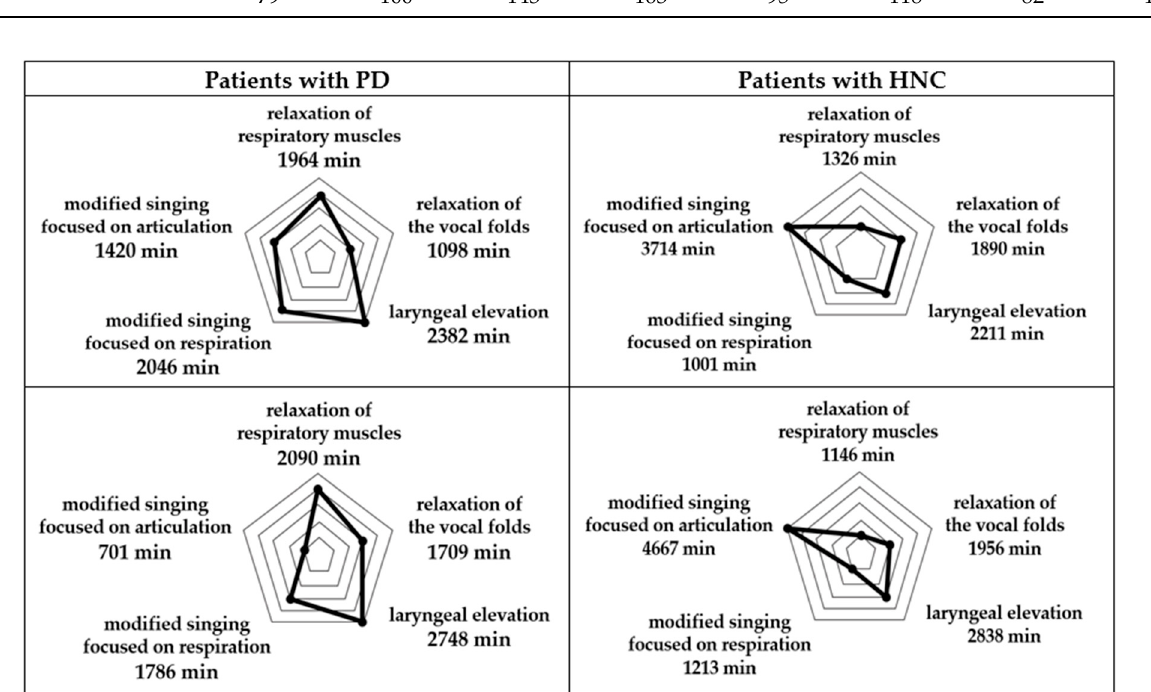
Figure 3. Repetition rate of each component within the protocol for each